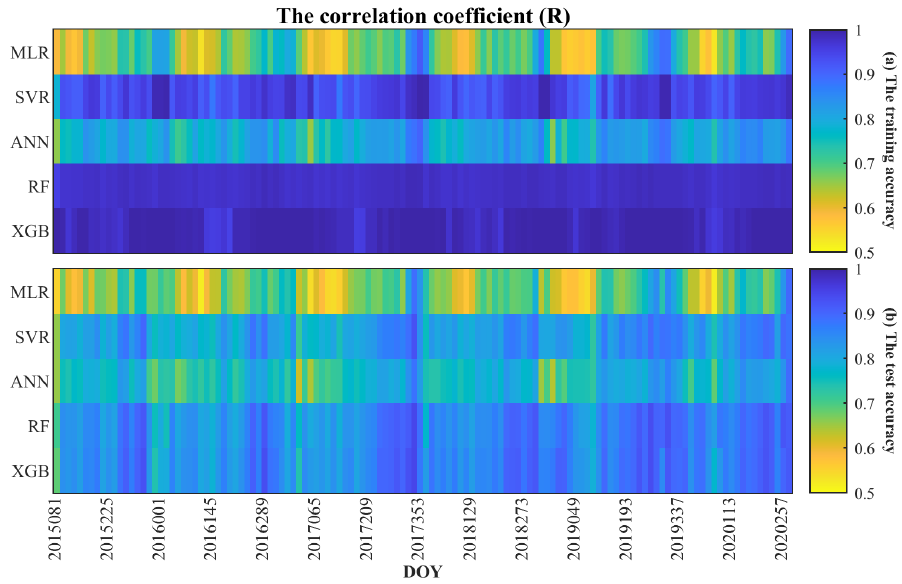
Figure 4. The correlation coefficient ( R ) of the models (MLR, SVR, ANN, RF and XGB) on different periods: (a) the training accuracy and (b) the test accuracy.